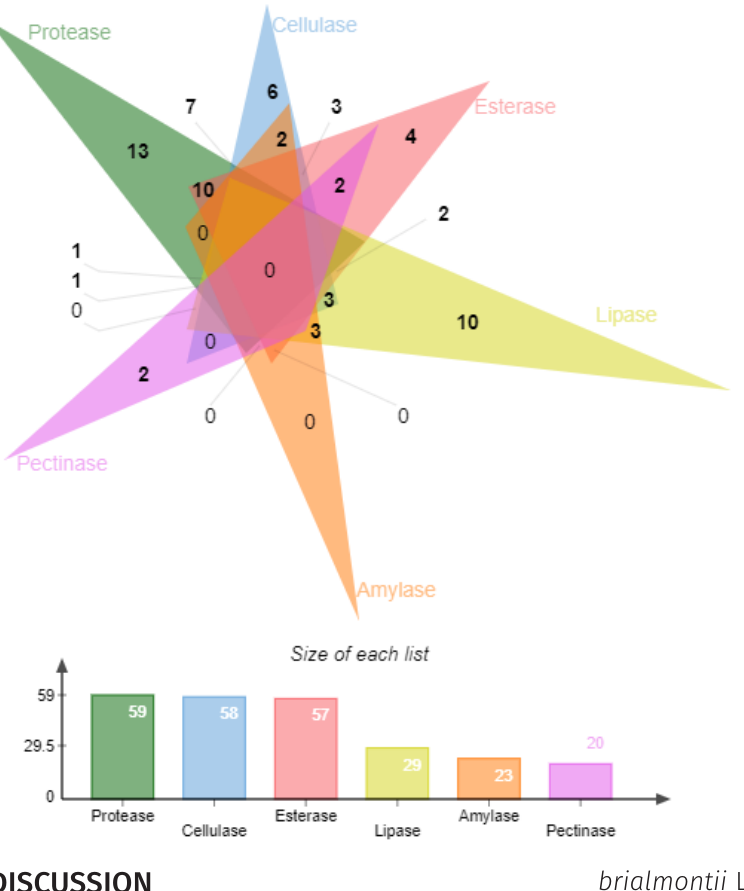
Figure 4. Venn diagram showing the distribution of enzymatic activity (protease, cellulase, esterase, lipase, amylase, and pectinase) among the yeasts isolated from Antarctic